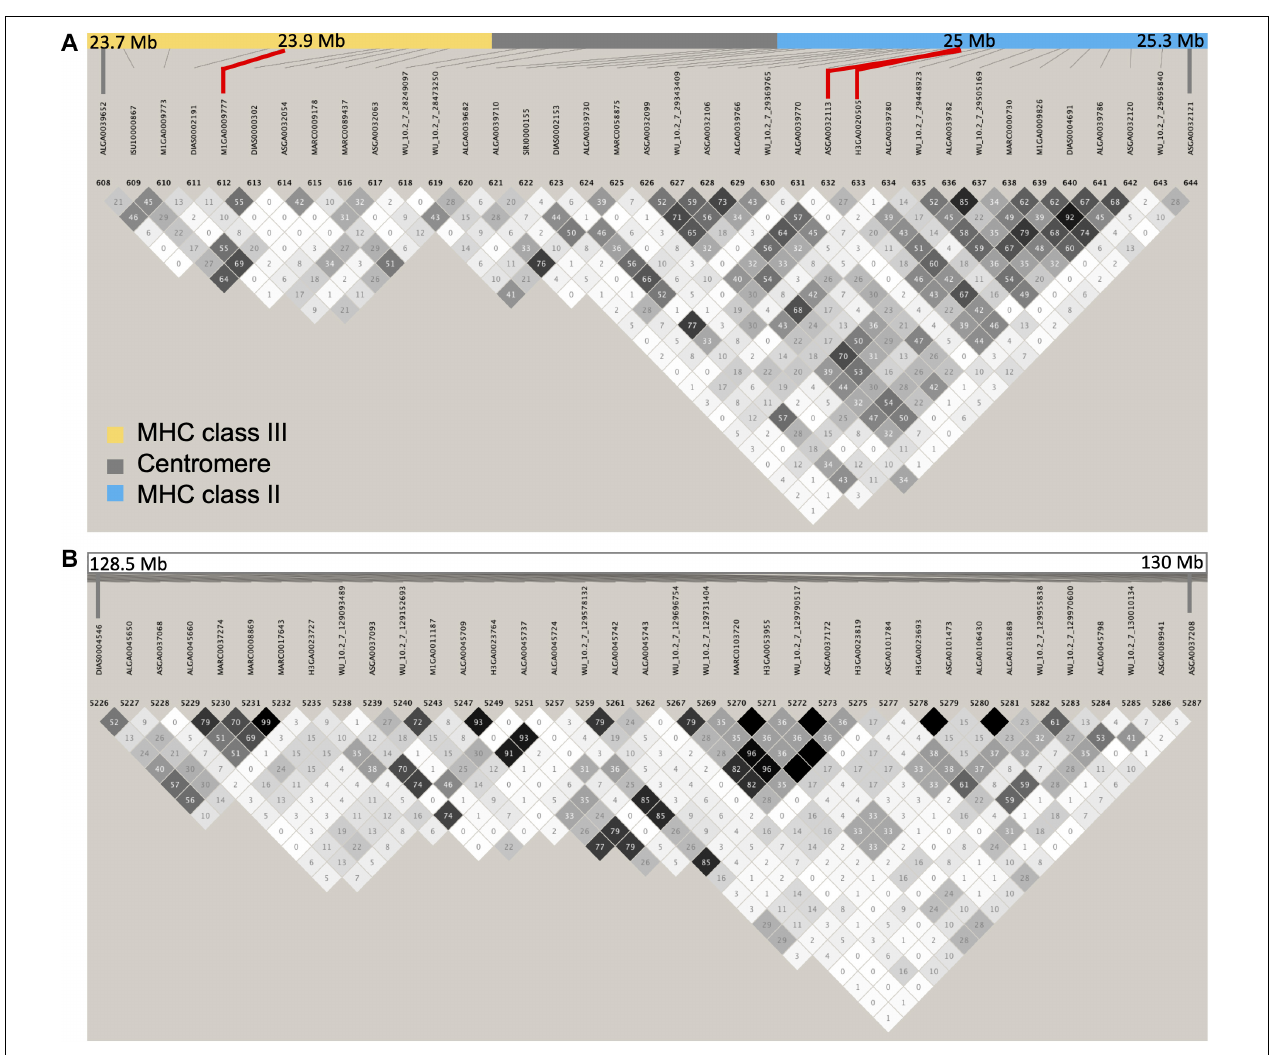
FIGURE 5 | Linkage disequilibrium (LD) map. Plots represent LD map of the data used in our study for the (A) major histocompatibility complex (MHC) region (chromosome 7: 23–26 Mb) and (B) the quantitative trait locus (QTL) previously identified for sample-to-positive (S/P) ratio by Serão et al. (2014, 2016). The SNPs explaining greater proportion of the genetic variance for S/P ratio to porcine reproductive and respiratory syndrome virus vaccination (ASGA0032113, M1GA0009777, and H3GA0020505) and reproductive performance (H3GA0020505) are shown in red in panel (A) . The MHC regions class II ( ∼ 24.7–25.3 Mb) and class III ( ∼ 23.6–24.3 Mb) are in blue and yellow, respectively, separated by the centromere ( ∼ 24.3–24.7 Mb) being shown in gray. Differently than in Serão et al. (2014), our region on SSC 7 between 128.5 and 130 Mb (B) for their proposed QTL showed overall low